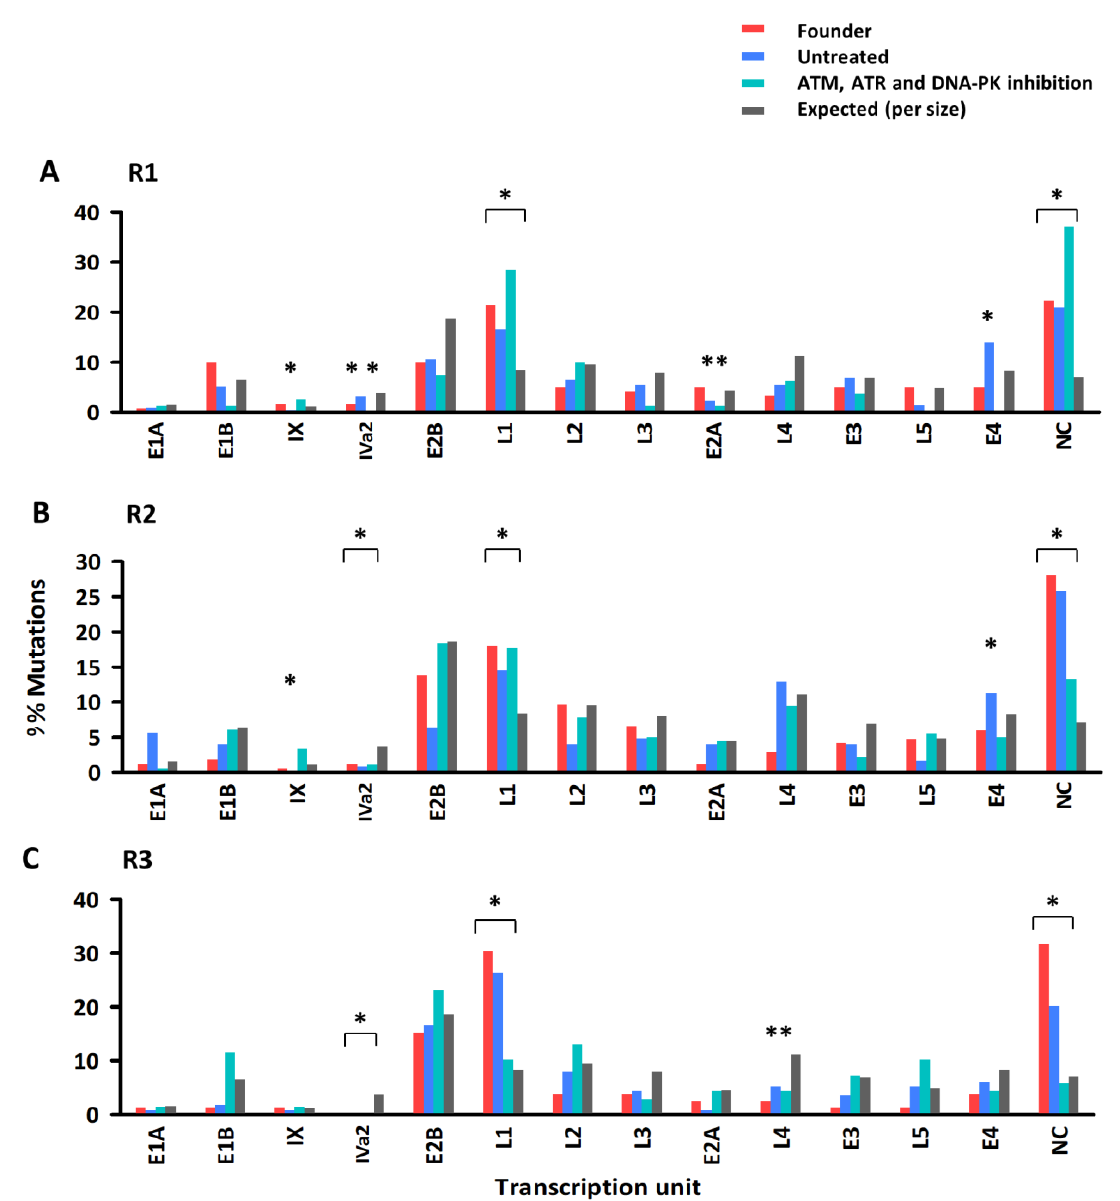
Figure 2. Mutation counts per adenovirus coding region. The number of mutations detected in each Ad5 transcriptional unit is shown for each evolution line ( A : R1, B : R2, C : R3) and treatment, compared to the corresponding founder virus of this line. Observed mutation counts (colors) are shown versus expected counts assuming a constant genome mutation rate (grey). NC: non-coding regions (pooled). * p < 0.05 (Chi-square test).